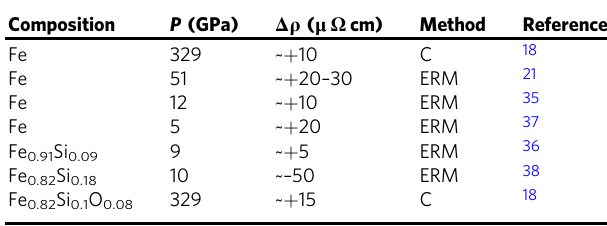
Method: C calculation, ERM electrical resistivity